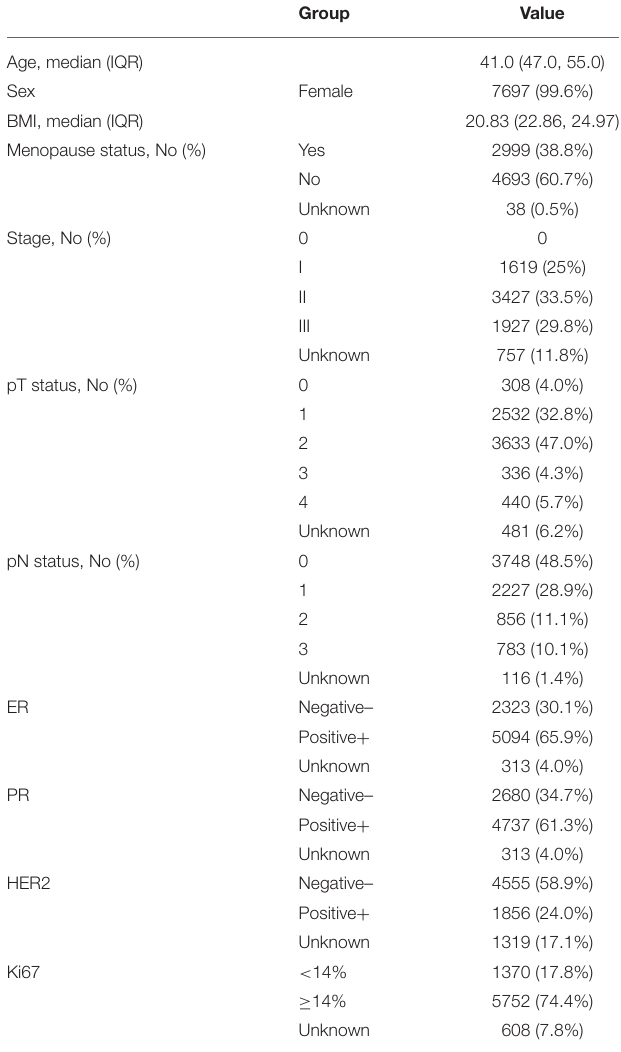
TABLE 1 | Characteristics description among breast cancer patients at